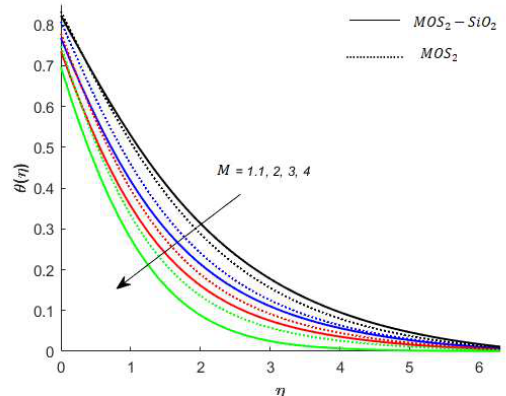
Figure 8. Variation in temperature for 𝑀 when 𝑃𝑟 = 2.36,𝐸𝑐 = 0.01,𝑆𝑐 = 0.8,(𝐺𝑟) (cid:3030) = 0.1,𝐾 = 0.1,𝐵𝑖 = 0.05,𝛽 ∗ = 0.1,and 𝑆𝑟 = 0.1.